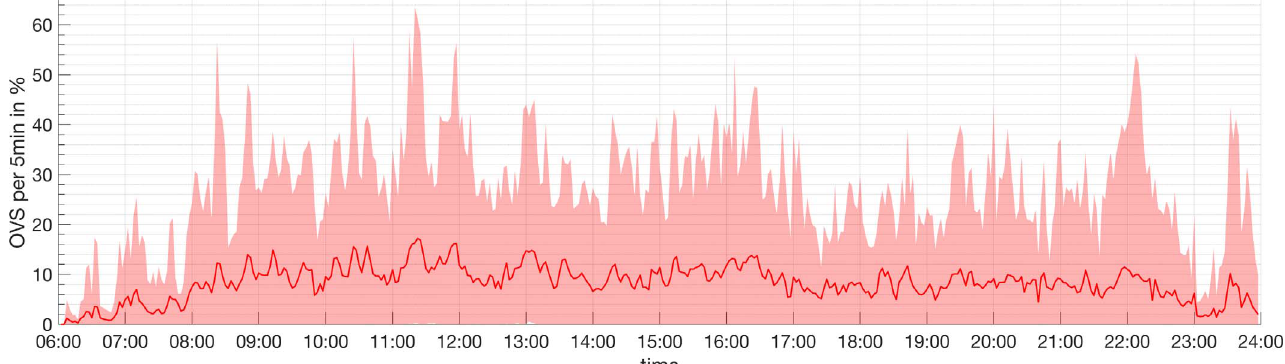
Figure 4. Time course of predicted OVS percentages in intervals of 5 min with 50% overlap, averaged over all participants and recording days. The solid line gives the mean values and the shaded area covers the 10th to 90th